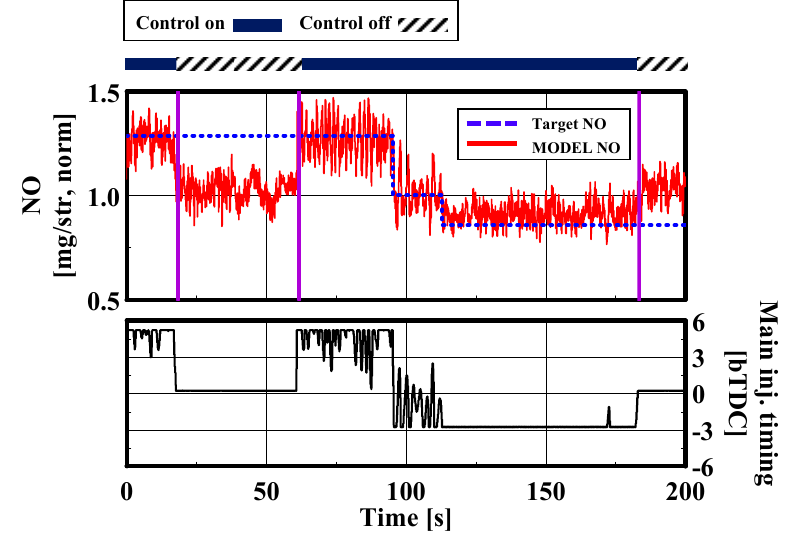
Figure 10. Engine-out NO emission control during steady-state conditions (1500 rpm, 25 mg/str).